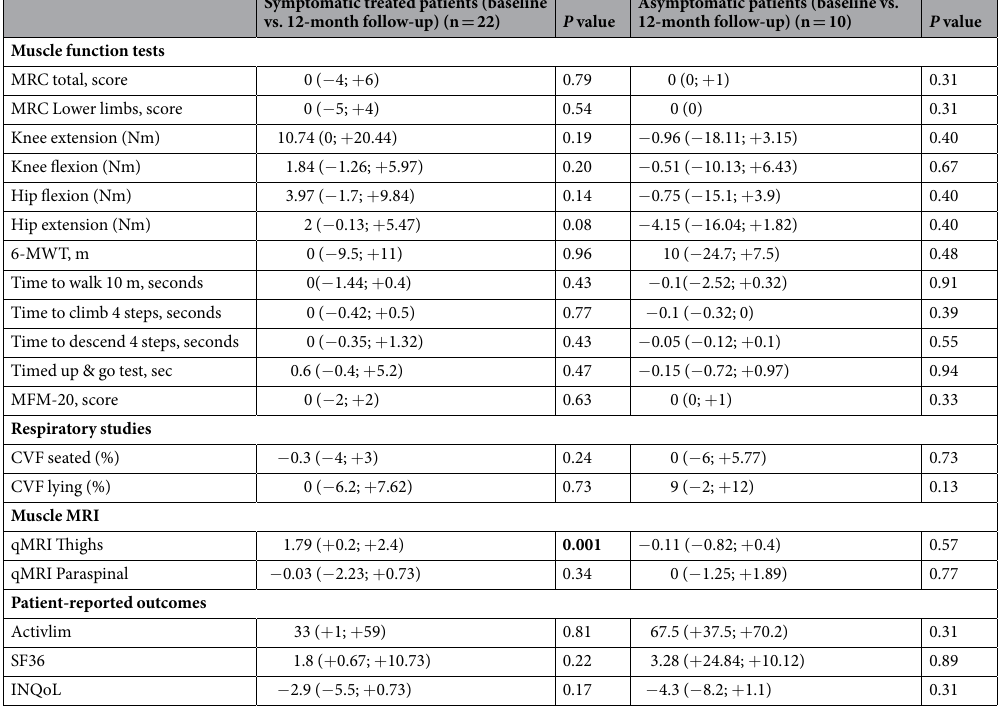
Table 4. Change between baseline and year 1 evaluation in muscle function tests, spirometry, quantitative muscle MRI and patient reported outcome measures in symptomatic and asymptomatic LOPD patients. Median value and 25th–75 th percentiles are shown. Paired Wilcoxon signed rank test was used to find out whether the differences observed between baseline and year 1 evaluation were statistically significant. Adjustment for multiple comparisons using Bonferroni correction was applied; p was considered significant if lower than 0.002.